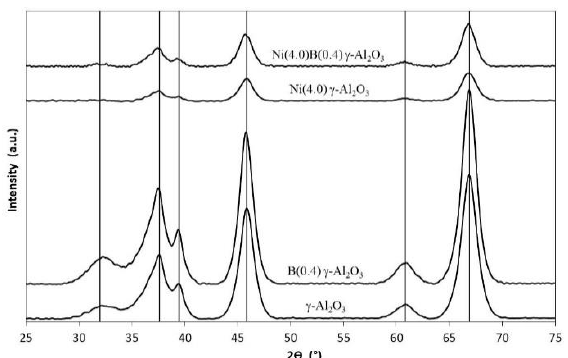
Figure 1. XRD di ff ractograms obtained for the di ff erent adsorbents. The characteristics di ff raction lines Figure 1. XRD diffractograms obtained for the different adsorbents. The characteristics diffraction of γ -Al 2 O 3 (——–) are indicated as lines of γ-Al 2 O 3 (––––) are indicated as reference.